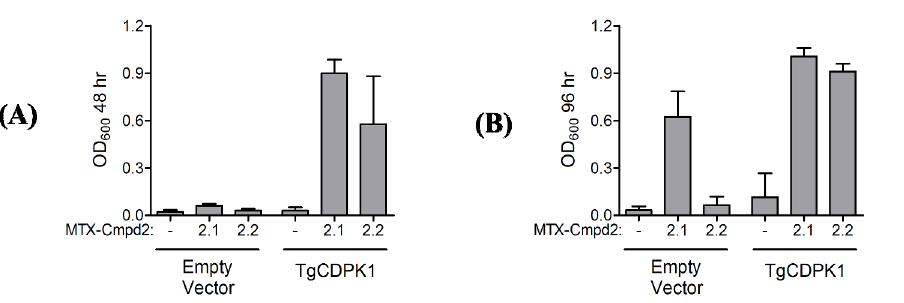
Figure 4. Comparison of the interaction of MTX-Cmpd2.1 and MTX-Cmpd2.2 with a known kinase target of compound 2 . LEU2 reporter activation growth assay with yeast expressing a TgCDPK1-AD fusion protein in the presence of MTX-Cmpd2.1 and MTX-Cpmd2.2 . Growth was assessed at ( A ) 48 hour and ( B ) 96 hour by measuring the of the yeast culture. Samples treated with the DMSO vehicle were used as negative OD 600 controls. Mean values ± SD are shown (n =